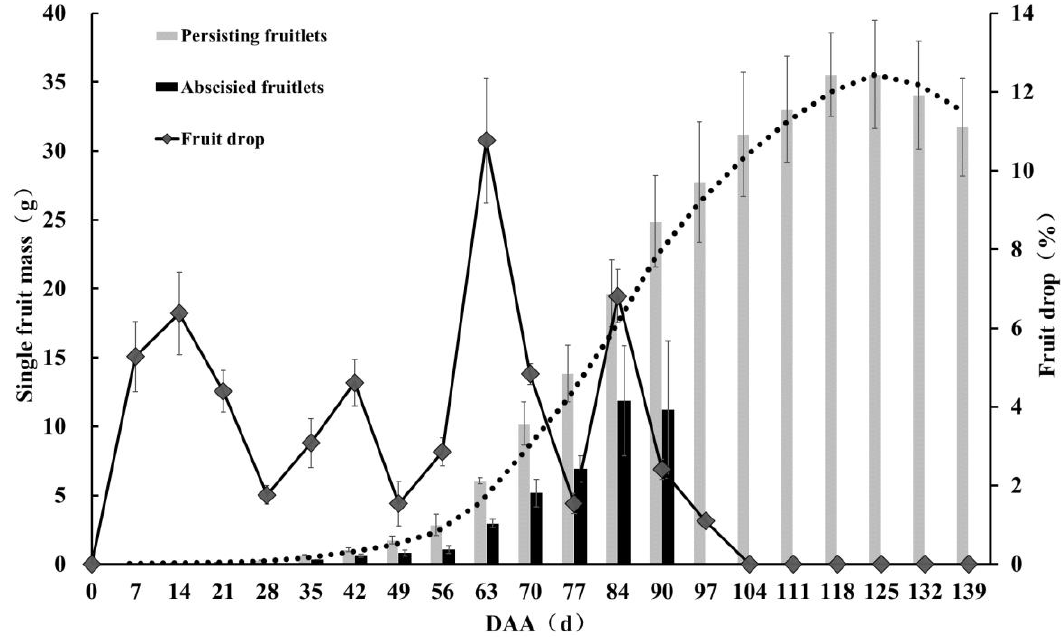
Figure 1. Analysis of pecan ‘Pawnee’ fruit development and drop dynamics. Black dot line indicates the fruit development dynamic trend. Mean values (±SD) of three biological replicates are shown. DAA, days after anthesis.